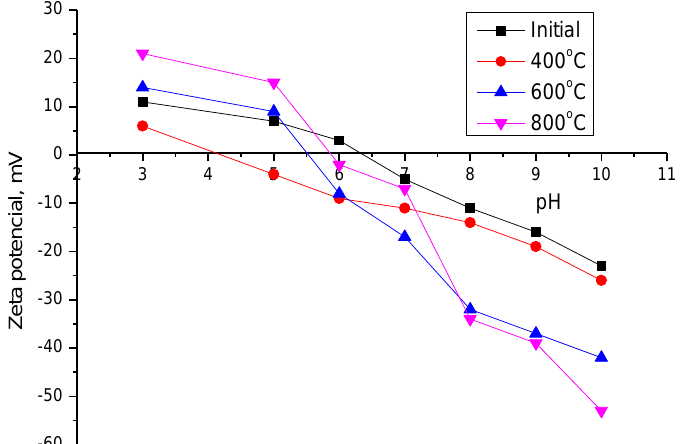
Figure 3. Dynamics of changes of zeta potentials in the process of nanoparticles annealing.